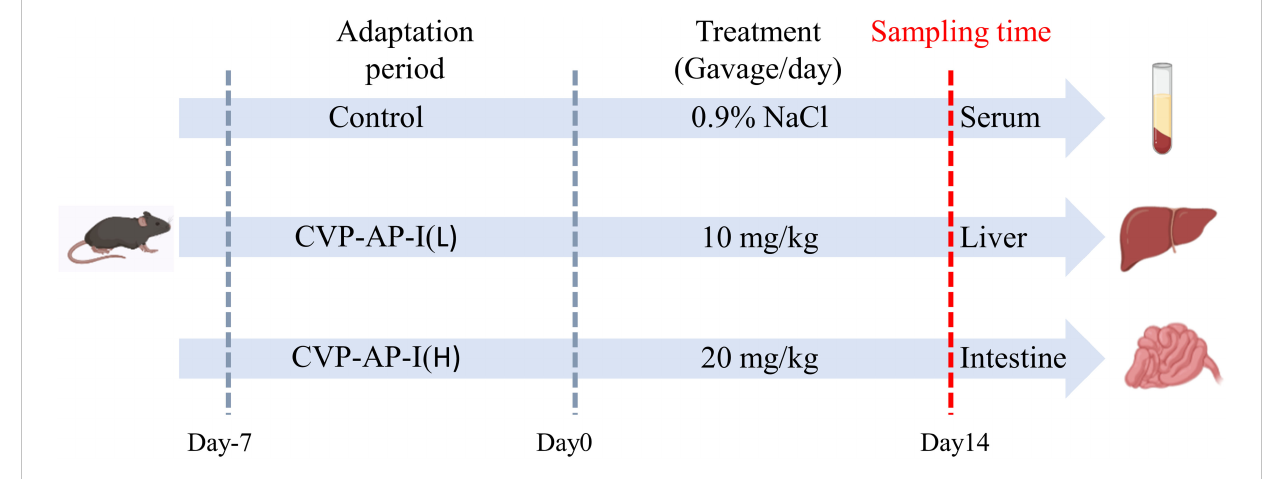
FIGURE 1 Schematic overview of experimental